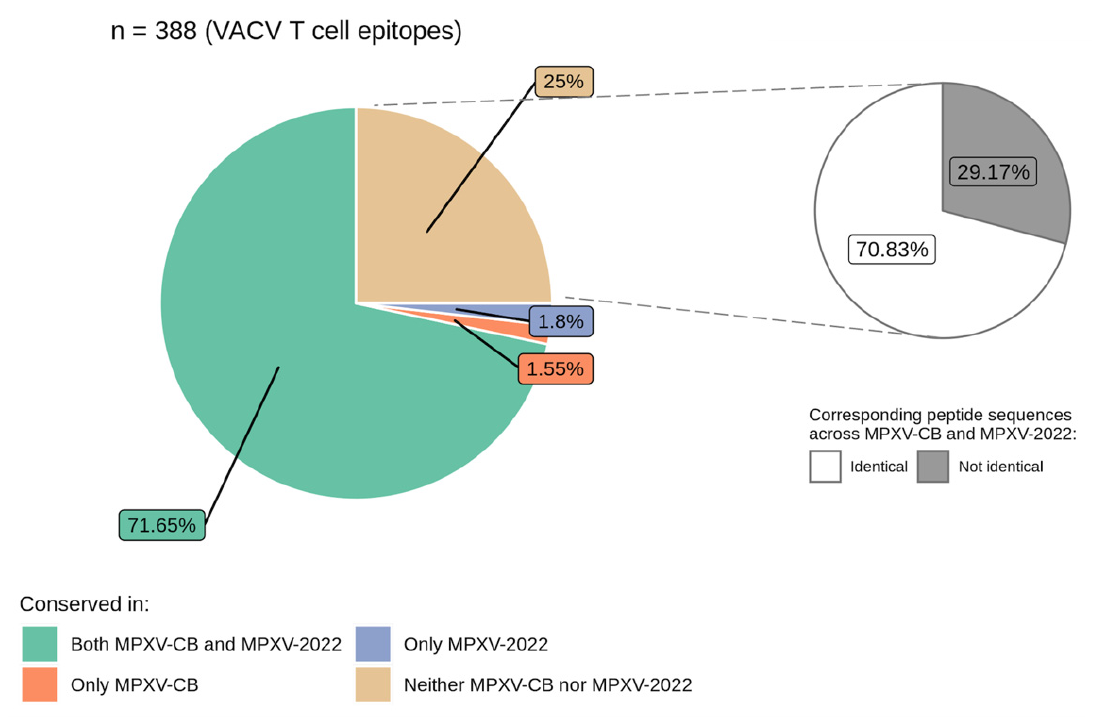
Figure 3. Distribution of the VACV T cell epitopes (n = 388) conserved among MPXV-2022 and MPXV-CB.